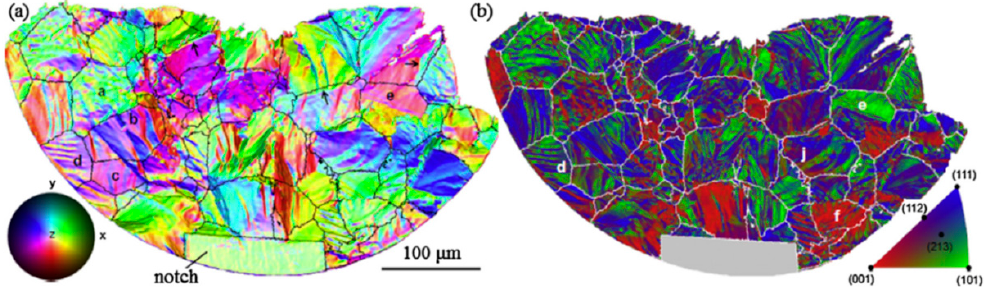
Figure 13. Fatigue crack from a 150 × 40 × 2 µ m 3 notch in Ti β 21S [55]: ( a ) the inclination of the crack to the z-axis using the stereographic projection from a standard µ CT image; and ( b ) the crystallographic orientation of the crack from DCT. The black and white lines in ( a , b ), respectively, indicate intersections of the crack with the grain boundaries.